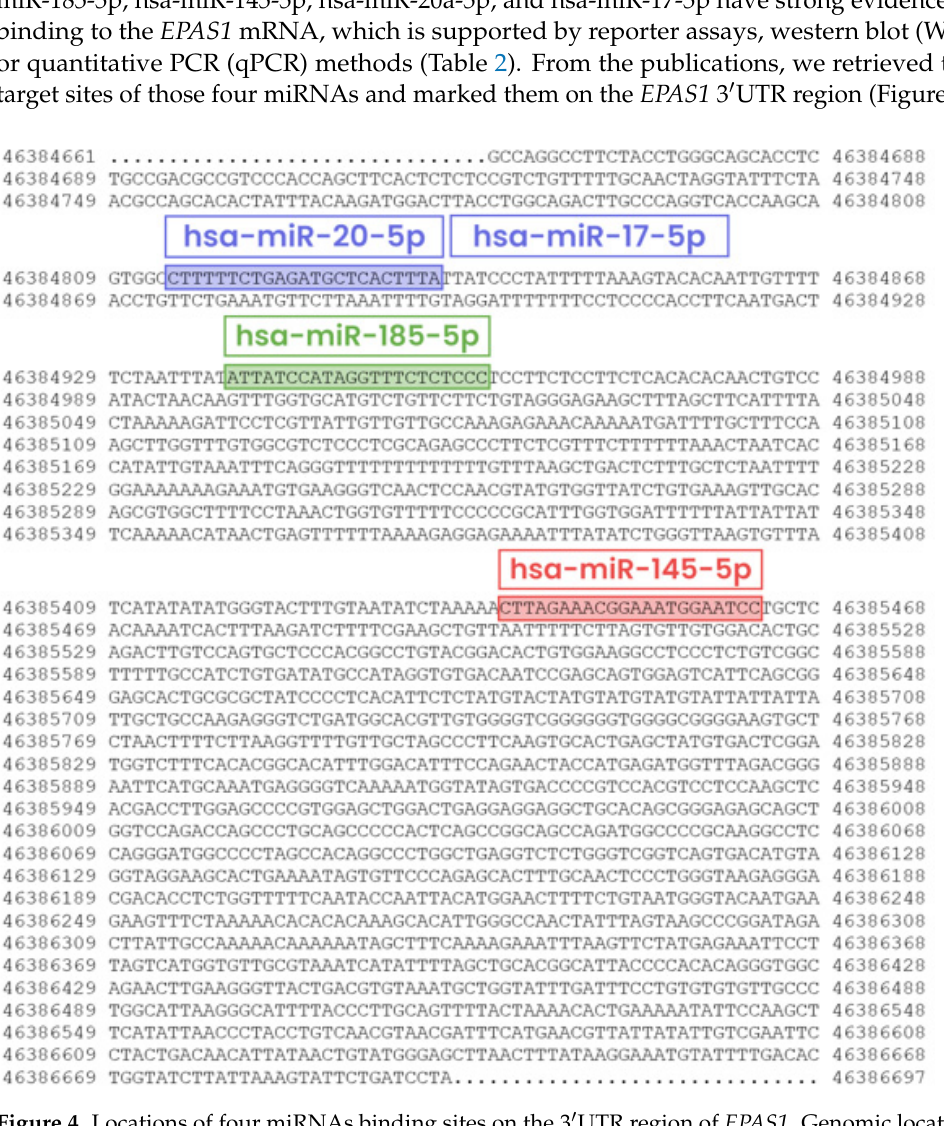
Figure 4. Locations of four miRNAs binding sites on the 3 ′ UTR region of EPAS1. Genomic location of the 3 ′ UTR region is from 46,384,661 to 46,386,697 bps (genome assembly GRCh38) . The EPAS1 protein has also been a target for long non-coding RNAs (lncRNAs). Zhu et al. (2021) showed that the lncRNA zing finger antisense 1 (ZFAS1) interacted with the EPAS1 protein and up-regulated the protein levels of EPAS1. The exact mechanism for upregulation of EPAS1 is still unknown